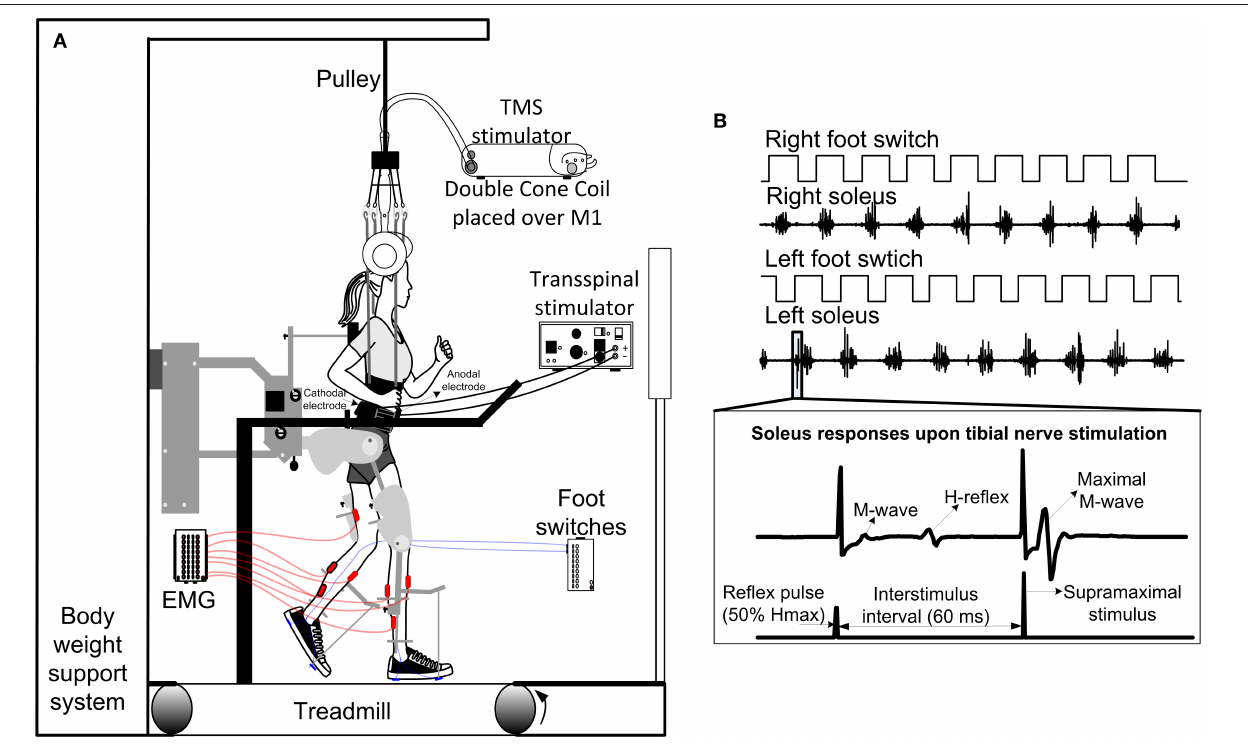
FIGURE 2 | Intervention and experimental protocol during stepping. (A) Stimulation of the spinal cord (transspinal) and brain (TMS via a magnetic coil) was delivered during assisted stepping. Subjects stepped with the robotic gait orthosis system while body weight support (BWS) was provided by a harness attached to a pulley. The magnetic coil was held in place using a chin strap and was checked regularly during the training session. Stimuli were triggered based on the signal from the right foot switch registering heel contact and were delivered only during the stance phase. (B) Left and right foot switch signals recorded simultaneously with right and left soleus EMG, and stimulation pulses delivered to the posterior tibial nerve. At each bin of the step cycle, a supramaximal stimulus was delivered to the tibial nerve 60ms after the test stimulus to evoke a maximal M-wave that was used to normalize the associated M-wave and H-reflex at each bin of the step